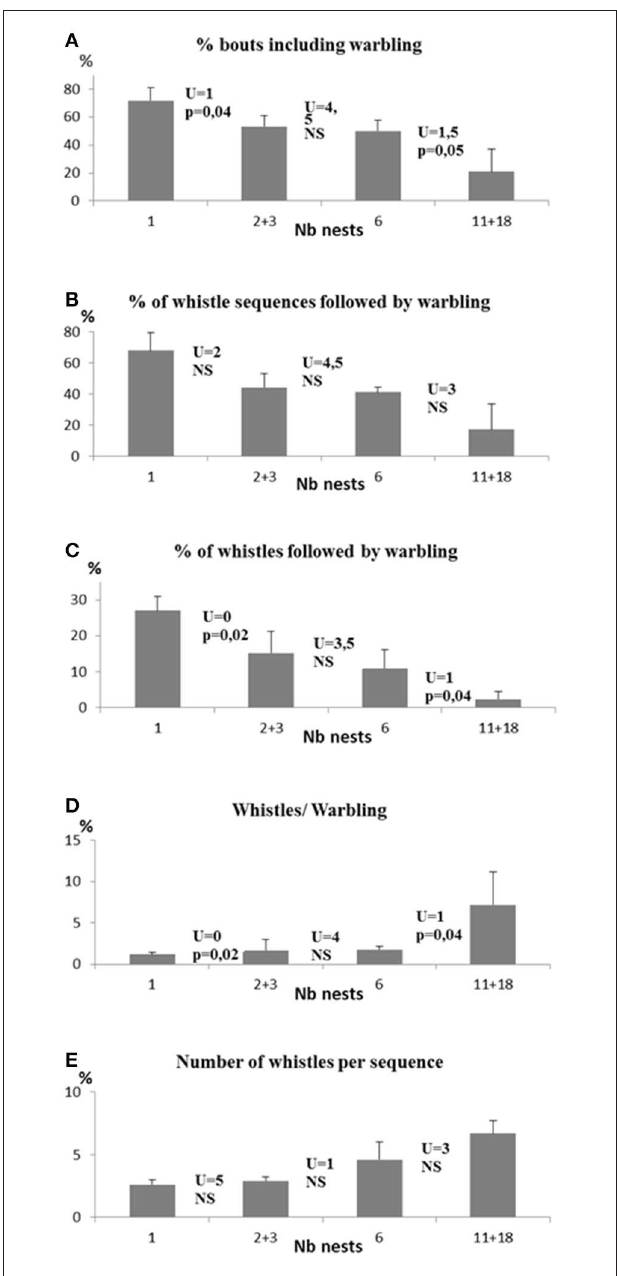
FIGURE 2 | Differences in song characteristics according to the size of the colony. (A) % of bouts including warbling; (B) % of whistle sequences followed by warbling; (C) % of whistles followed by warbling; (D) ratio Whistles/Warbling; (E) number of whistles per